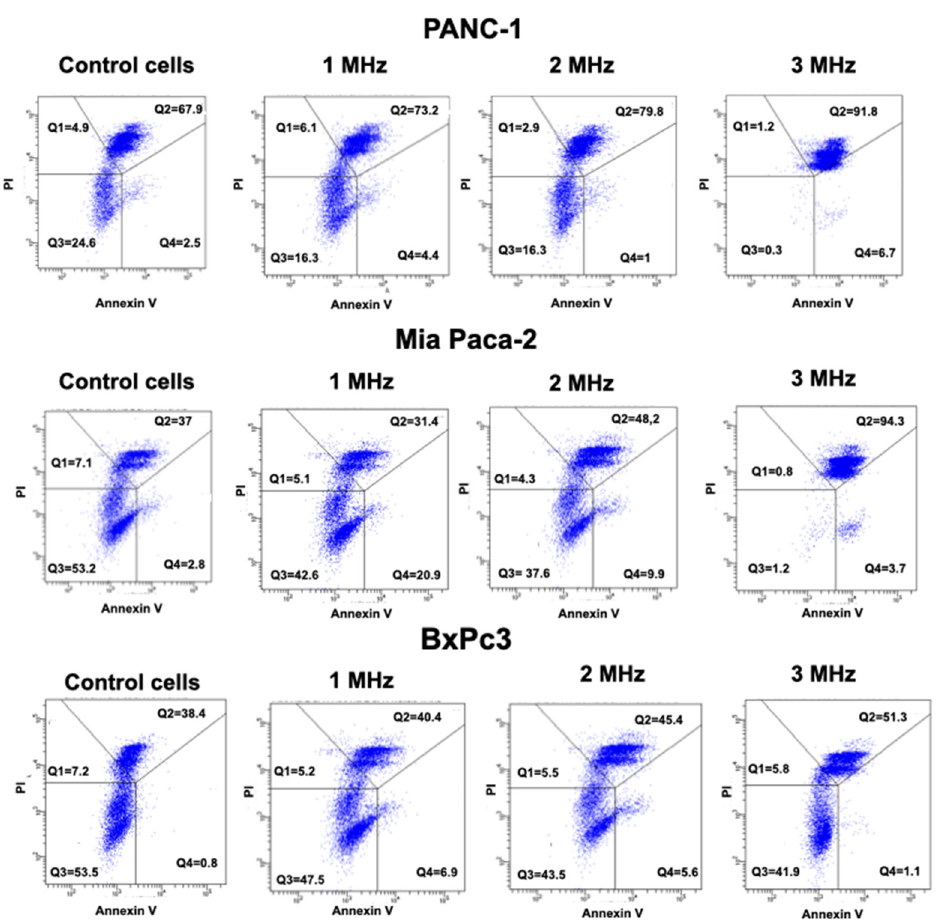
Figure 9. Results of Annexin Pi staining performed on PANC-1, Mia Paca 2 and BxPc3 cells. Viable cells are negative for both Annexin V and PI (Q3 quadrant gate in the dot plots); cells that are in the early phases of apoptosis are Annexin V positive and PI negative (Q4 quadrant gate in the dot plots); cells that are in the late phases of apoptosis are both Annexin V and PI positive (Q2 quadrant gate in the dot plots); and dead (necrotic) cells are Annexin V negative and PI positive (Q1 quadrant gate in the dot plots).